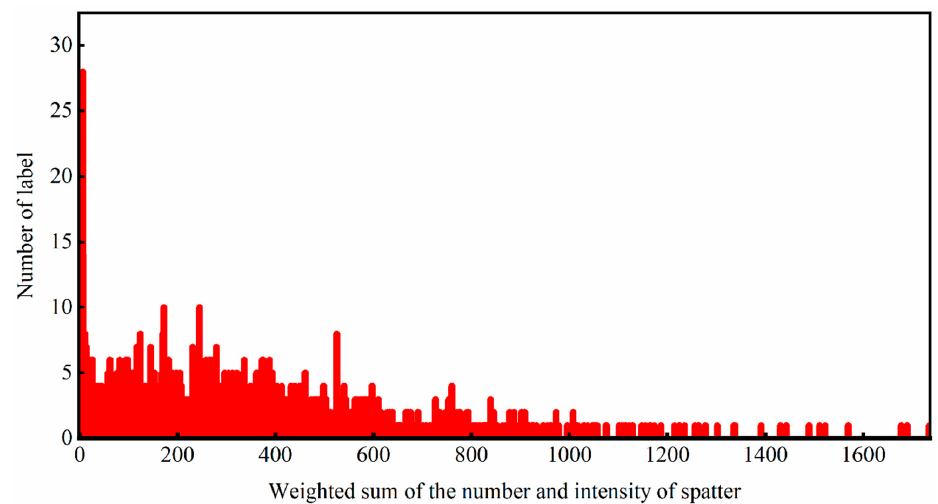
Figure 13. The histogram of the weighted sum of the number and intensity of spatter during SLM process.